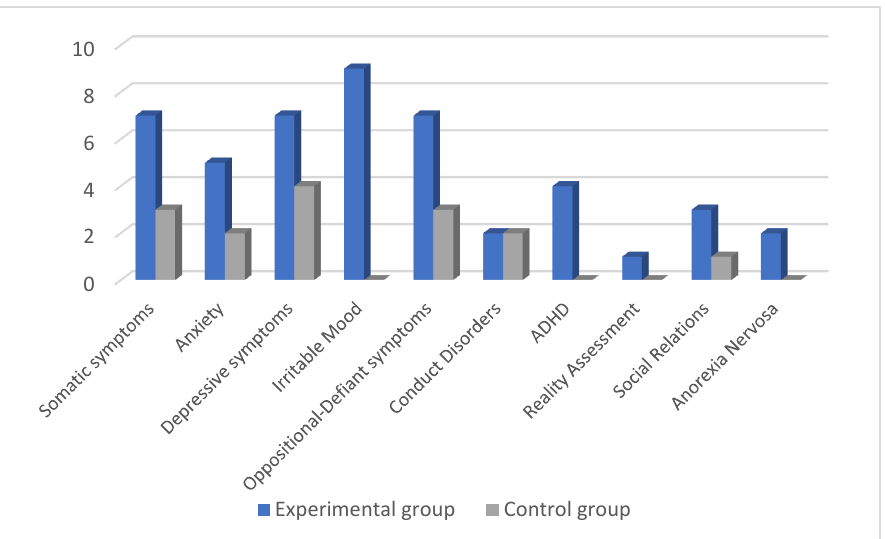
Figure 1. Number of subjects showing results above the cut-off in the CABI sub-scales in the EG and CG.